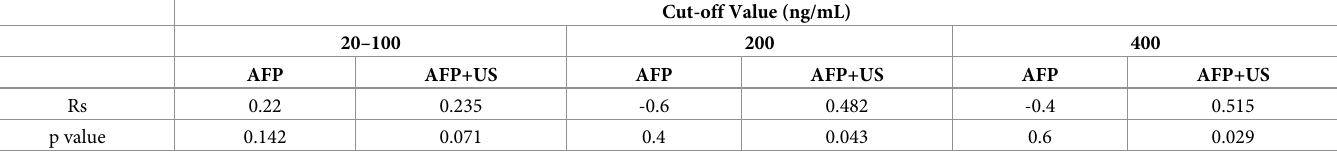
Table 4. Spearman correlation analysis